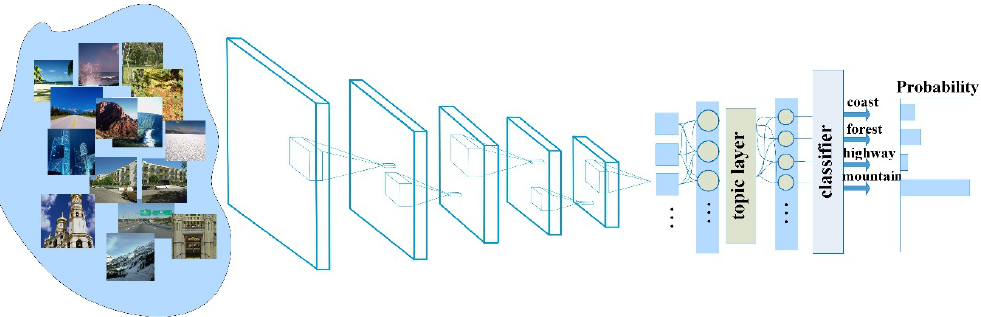
Figure 1. The architecture of our model.